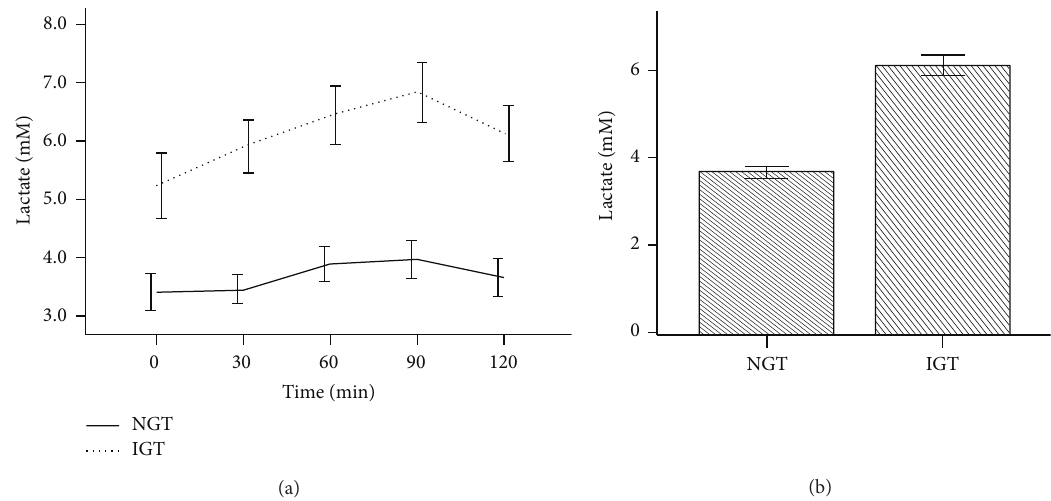
Figure 5: Lactate levels during OGTT according to glucose tolerance. OGTT was based on 75 g oral glucose tolerance tested over 120 min. Normal glucose tolerance (NGT) is based on glucose levels less than or equal to 140mg/dL at time 120min, and impaired glucose tolerance (IGT) is based on glucose levels 140–200 mg/dL at time 120 min. Plasma lactate was measured as shown in Study Subjects. (a) showed significantly higher levels of lactate among participants with IGT. The difference continued throughout the period of OGTT. (b) showed mean total lactate levels during OGTT. The cumulative lactate level among participants with IGT was significantly higher than those participants with NGT ( 𝑃 < 0.001 ).